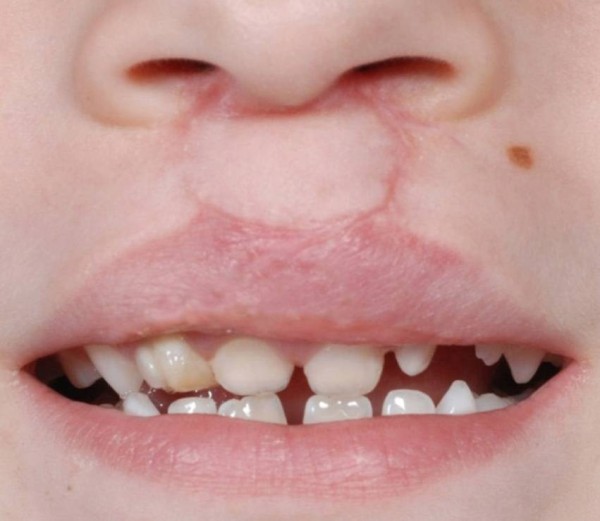
Detail of the postoperative situation in Figure 3with complete repair of the whistling defect.